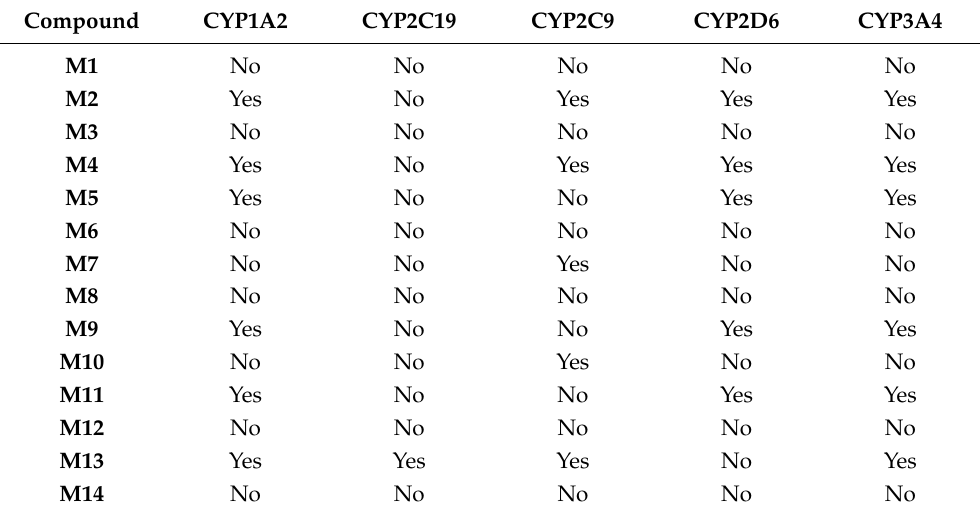
Table 7. The CYP-P450 enzyme inhibition profile of A. fragrantissima flower dichloromethane extract- derived metabolites using SwissADME